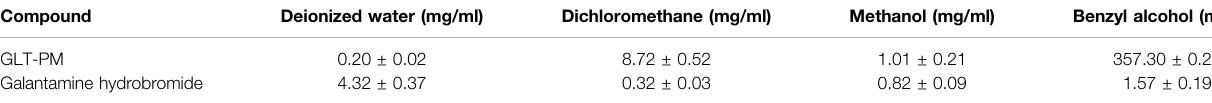
TABLE 3 | The solubility of GLT-PM and galantamine hydrobromide in different solvents (25 ° C, mean ± SD, n (cid:2) 3). Compound Deionized water (mg/ml) Dichloromethane (mg/ml)